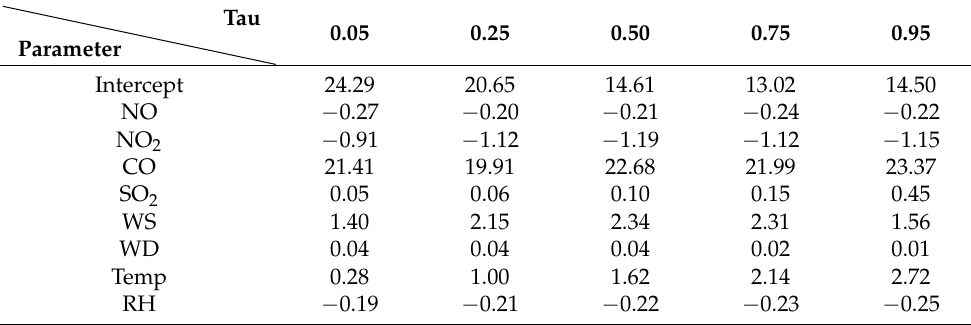
Table 3. Model coefficients at different quantiles (tau) of O 3